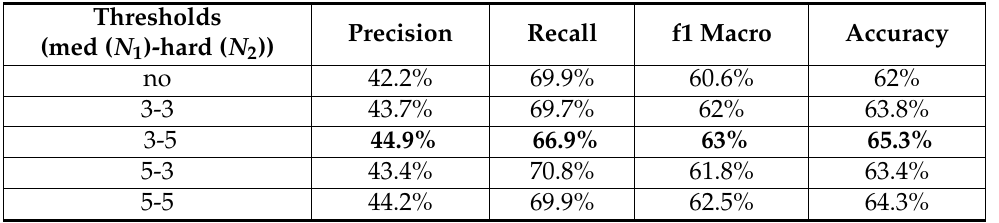
Table 5. Random Forest performance metrics for different parameters of the post-processing tech- nique described in Section 3.4. Best result is indicated in